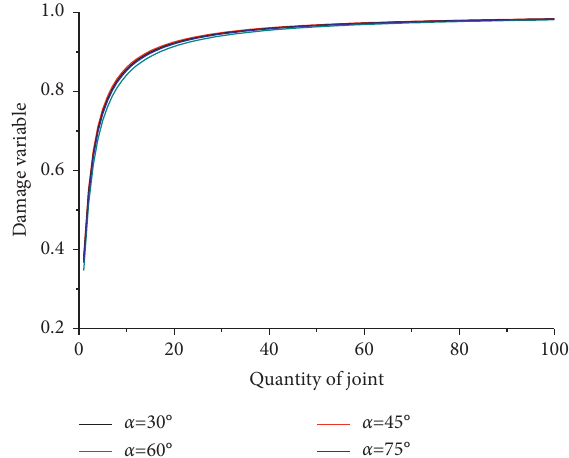
Figure 7: The change in the damage variable of coal with the number of joints.